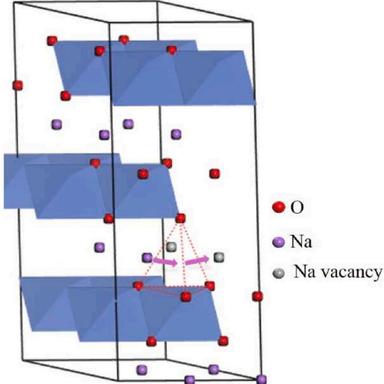
Schematic crystal structure of sodium migration path. The red dotted lines indicate an intermediate oxygen tetrahedron. Ni ion resides in the center of blue oxygen octahedron, which produces electrostatic repulsion to diffusing Na ion. (For interpretation of the references to colour in this figure legend, the reader is referred to the Web version of this article.)